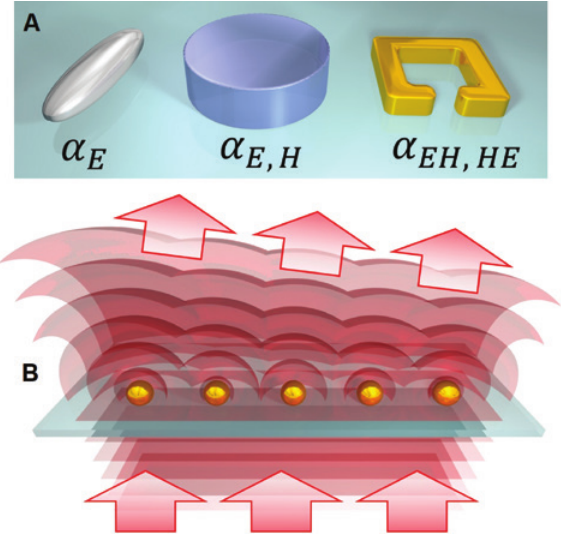
Figure 2: Typical metasurface building blocks. (A) Examples of metasurface scatterers: plasmonic nanoantenna for tailoring electric dipolar response (left); dielectric Mie resonator for tailoring electric and magnetic dipoles (middle); plasmonic split-ring resonator for tailoring magneto-electric coupling (right). (B) Illustration of the Huygens principle: wavefront shaping by phase gradient across the sources of spherical waves (phased